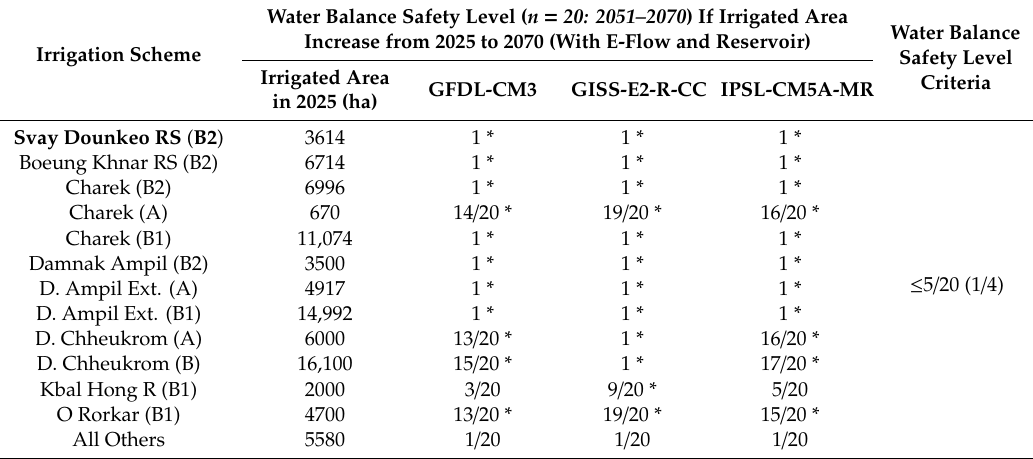
Table 11. The limited irrigated area for safety water balance and startup year of deficits.